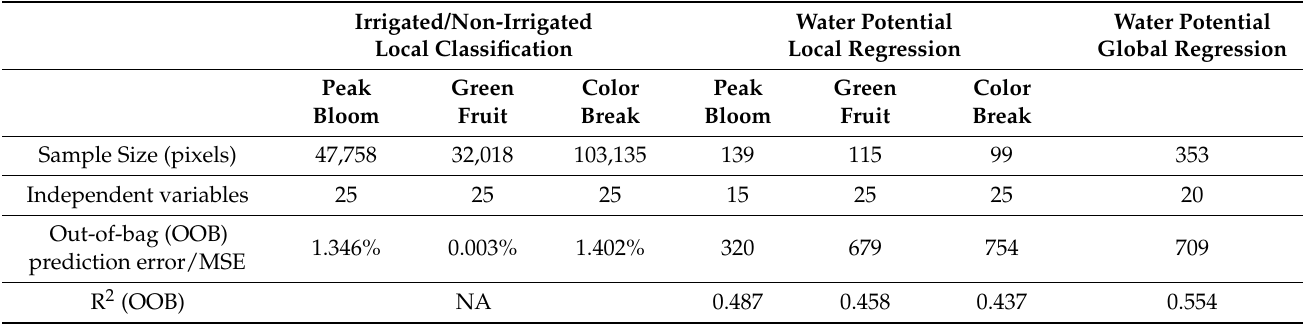
Table 1. Model information used in image classification with each collection stage having a separate model, and combined stages for global model regression. The table also includes out-of-bag prediction errors as percentages for classification, and mean squared error and R 2 values for regression.